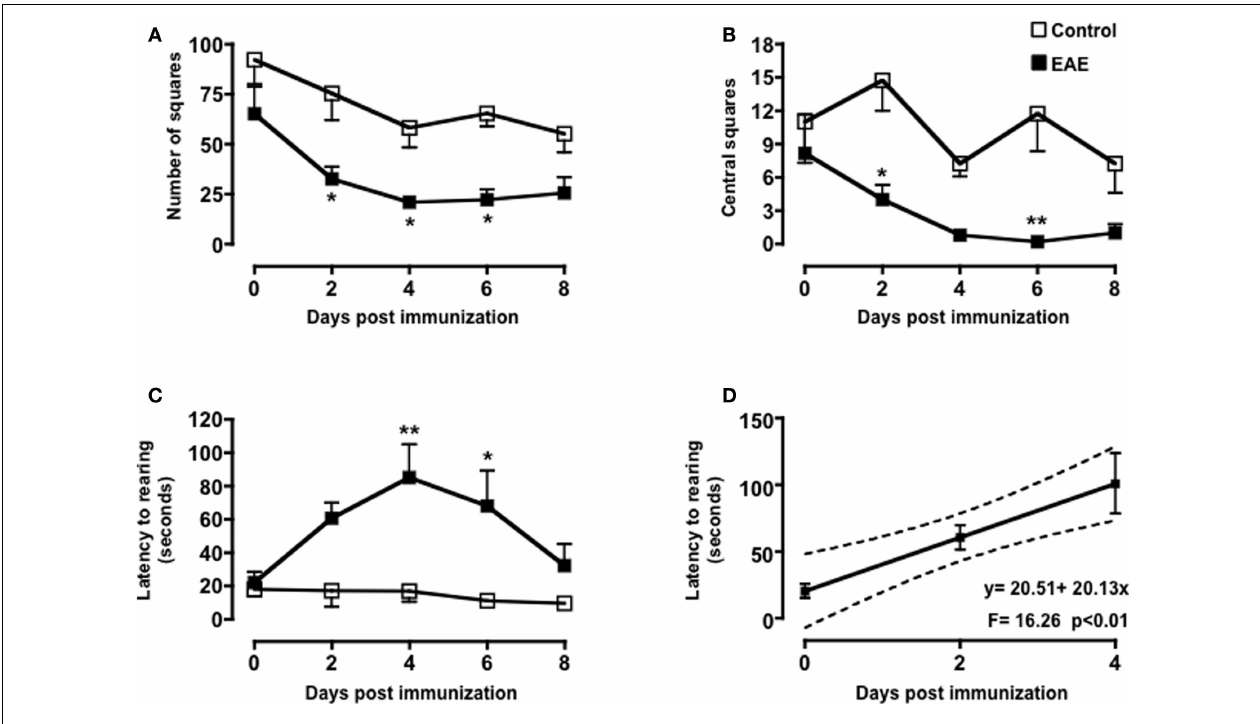
during a 5-min test.Values are expressed as mean ± SEM for six to eight mice and are representative of N = 5–6 separate experiments. * p < 0.05, ** p < 0.01 indicate significant values compared to control mice.